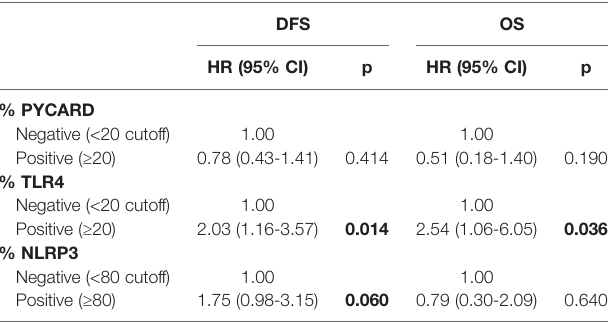
TABLE 5 | Multivariate analysis of DFS (disease-free survival) and OS (overall survival).